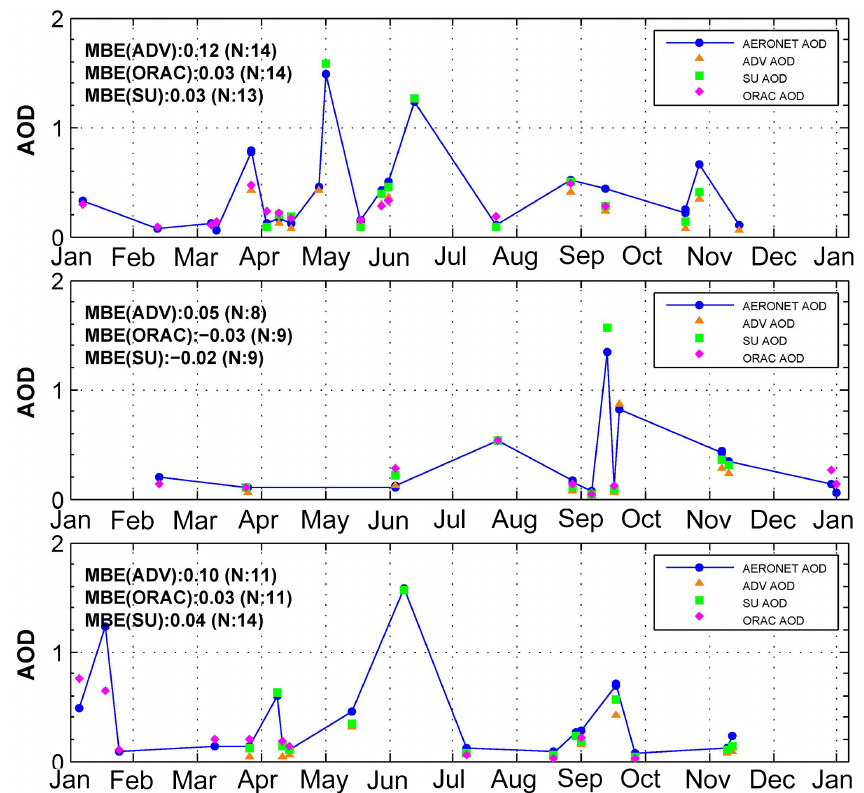
Figure 8. Time series comparison of AATSR AOD with AERONET AOD at Xianghe in 2007, 2008, and 2010.